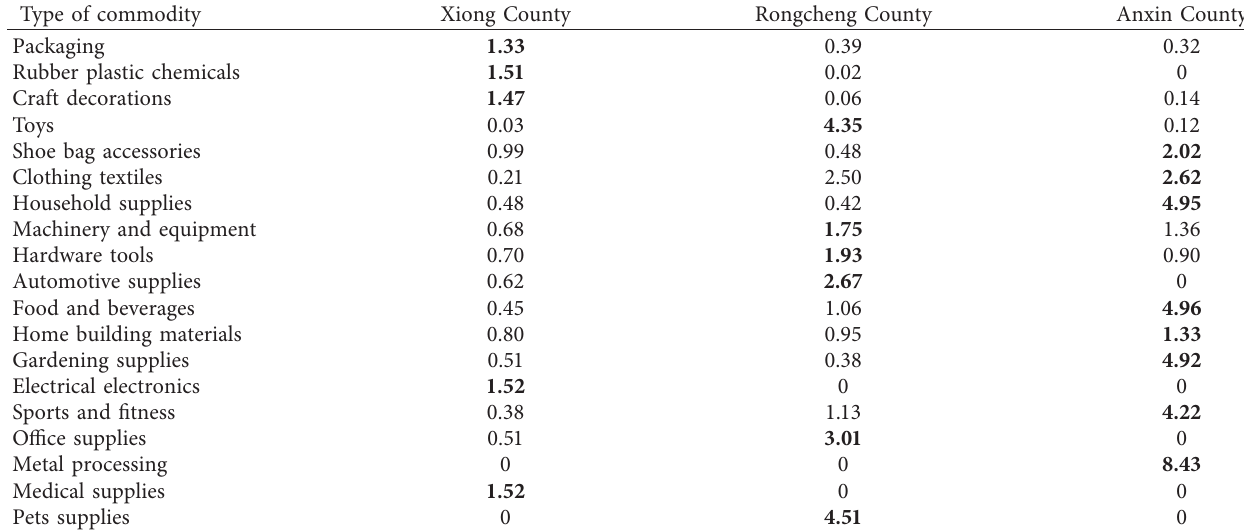
Table 3: Location entropy distribution of different types of e-commerce products in Xiong’an New Area. Type of